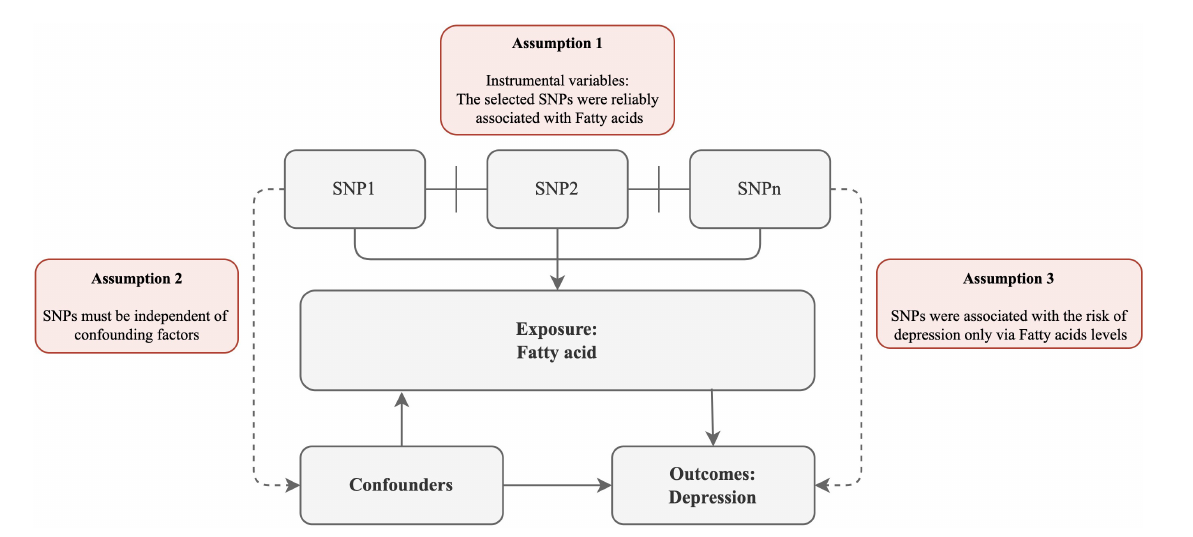
FIGURE1 Schematic diagram of the assumptions underpinning a Mendelian randomization analysis of the association between plasma fatty acid (FA) levels and depression. We performed a two-sample MR study to examine the potential causal links between FA and the risk of depression. The MR method relies on the following assumptions: (1) the selected SNPs were reliably associated with FA; (2) SNPs must be independent of confounding factors; (3) SNPs were associated with the risk of depression only via FA